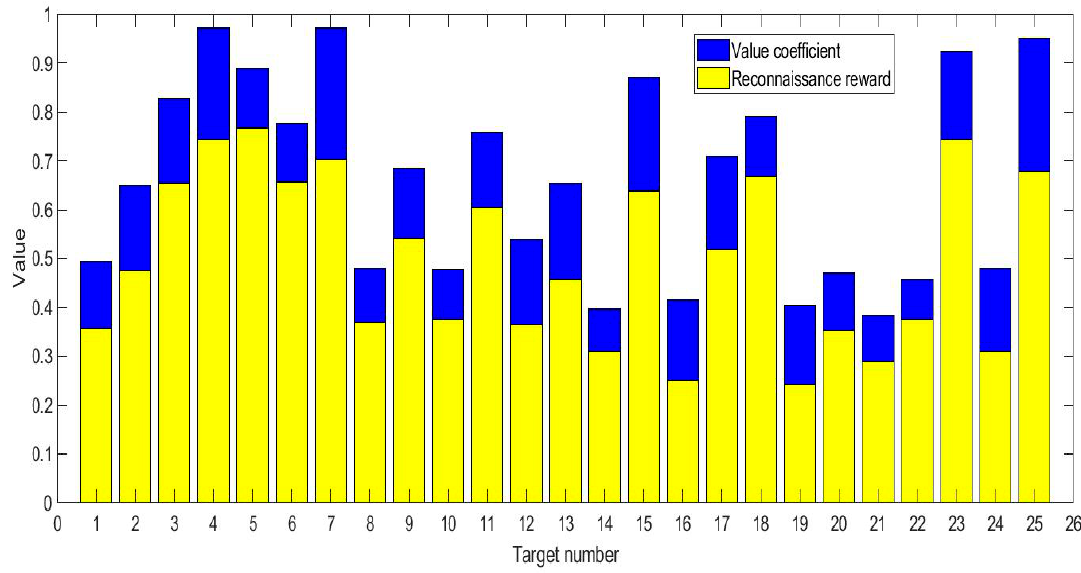
Figure 4. Value coefficient and reconnaissance reward of each target area in the scenario.